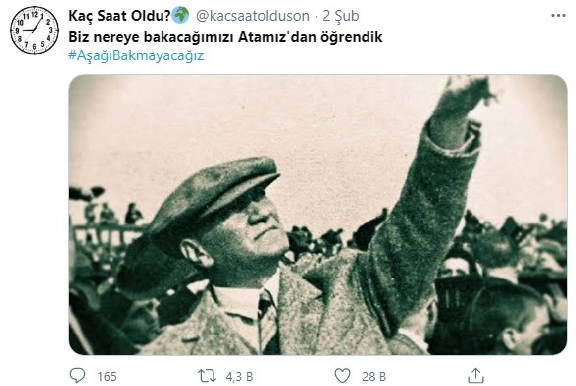
Figure 4. Counter‐trolls often refer to Atatürk in quarrels. Note: “We learned where to look from our Father” (trans‐ lation by the author). Source: Kaç Saat Oldu? (2021a).